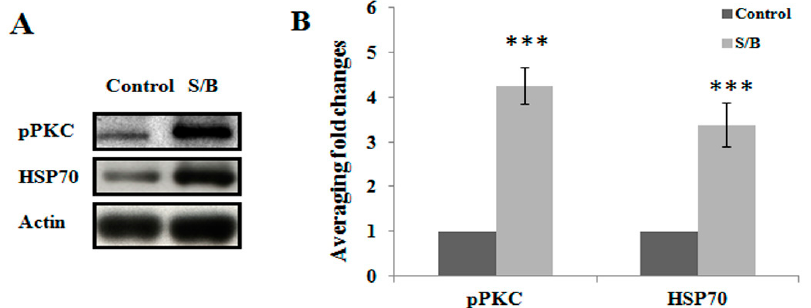
Figure 3. The effects of S/B remedy on levels of pPKC and HSP70 in neuronal/glial cultures, wherein ( A ) shows the protein expression of control or S / B-treated cultures, and ( B ) shows the quantitative results of pPKC or HSP70 expression levels in A. Data are expressed as means ± SEM from 5 independent experiments. The symbols “***” indicate statistical significance by one ‐ way ANOVA and Bonferroni t ‐ test at P < 0.001, S/B vs. Control.